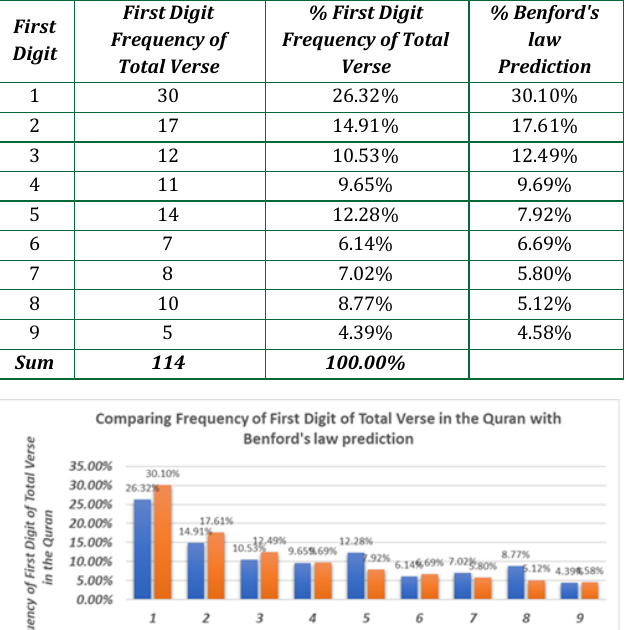
Table 1: Frequency percentage of first digit of total verse in the Quran is compared with frequency percentage of first digit predicted by the Benford’s law.